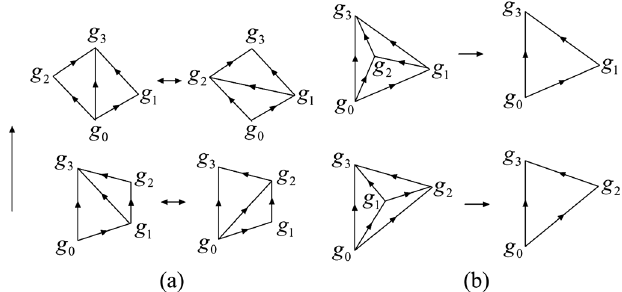
FIG. 16. All possible 2D (2-2) and (3-1) moves that admit a branching structure.